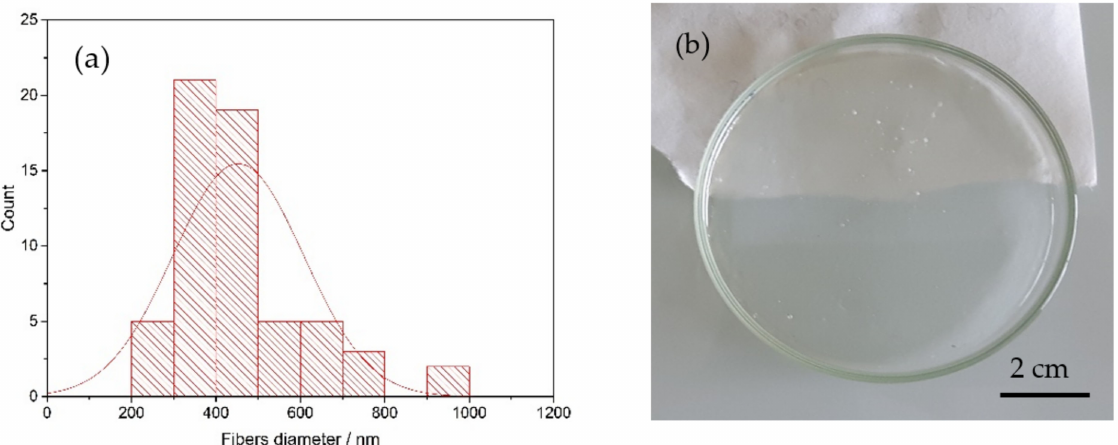
Figure 2. ( a ) Fibers diameter distribution of the PPSU electrospun mat and ( b ) a reinforced SPEEK membrane casted from ethanol and water (K-EW_R).